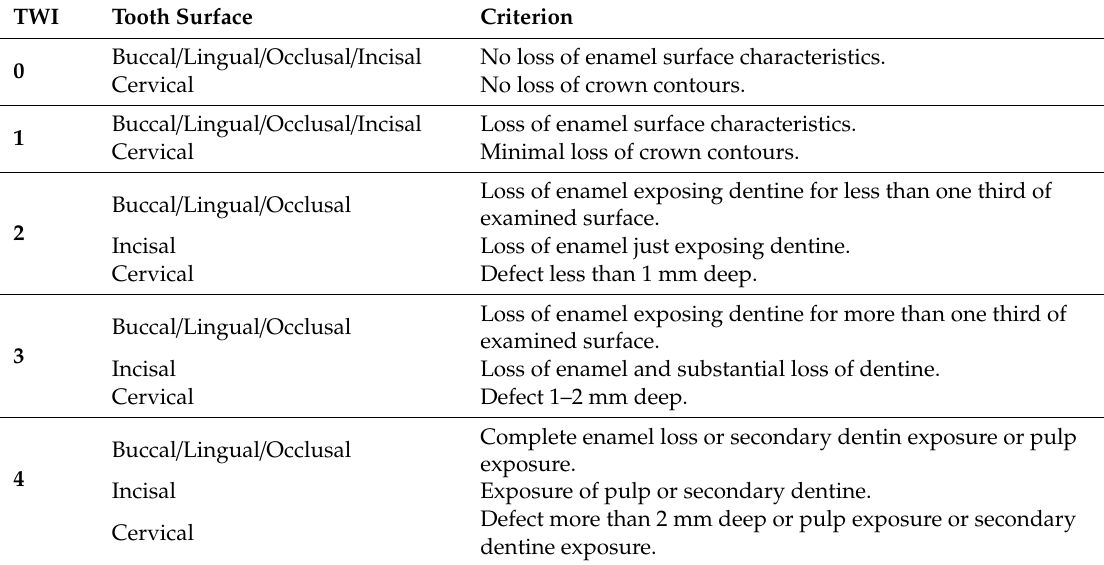
Table 2. Tooth Wear Index (TWI) according to Smith and